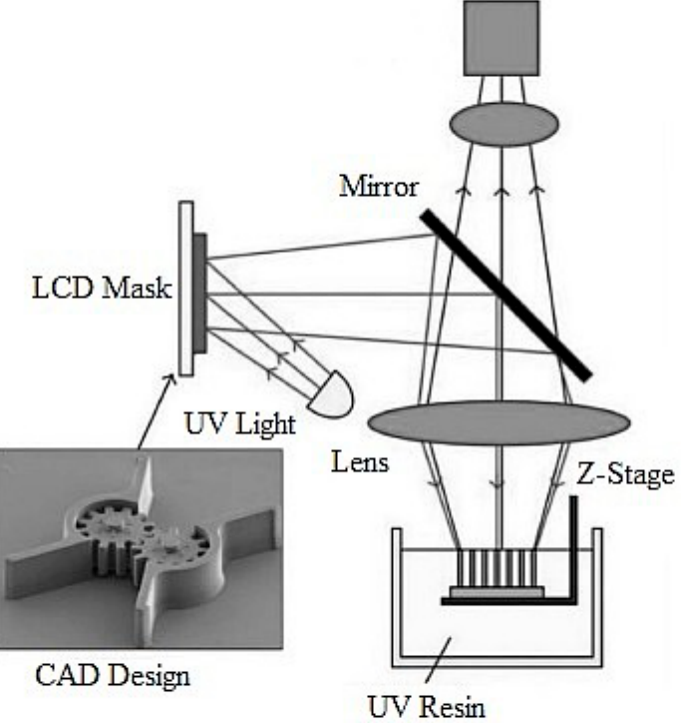
Figure 3. Schematic of the projection micro-stereolithography (P μ SL) method [62].